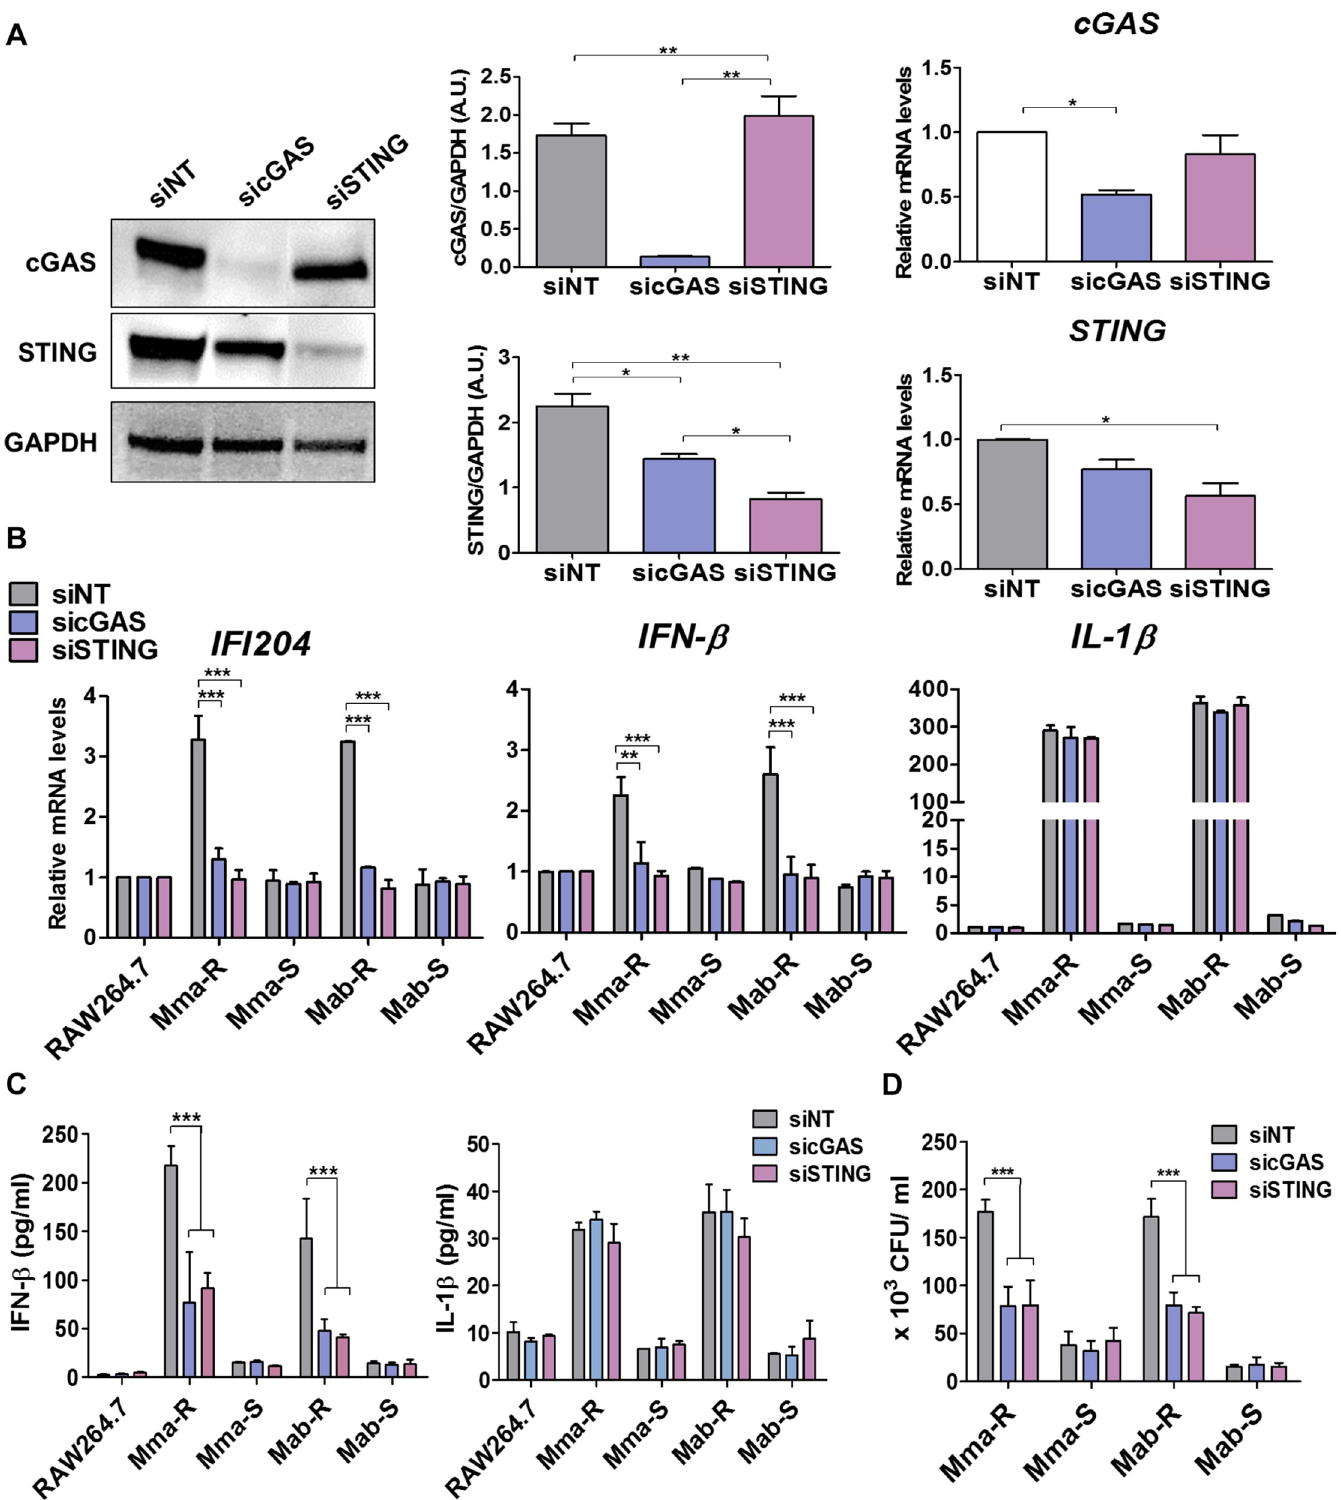
Fig 6. MAB-R infection enhanced IFN- β production via the cGAS − STING axis in infected murine macrophages. (A) RAW264.7 cells were transfected with siRNAs targeting cGAS or STING or a scramble siRNA (siNT). Forty-eight hours after transfection, protein and transcription levels were measured in total cell lysates by immunoblotting (left panels) and RT-qPCR (right panels), respectively. (B-D) RAW264.7 cells were transfected with cGAS, STING or a scramble siRNA (siNT). Forty-